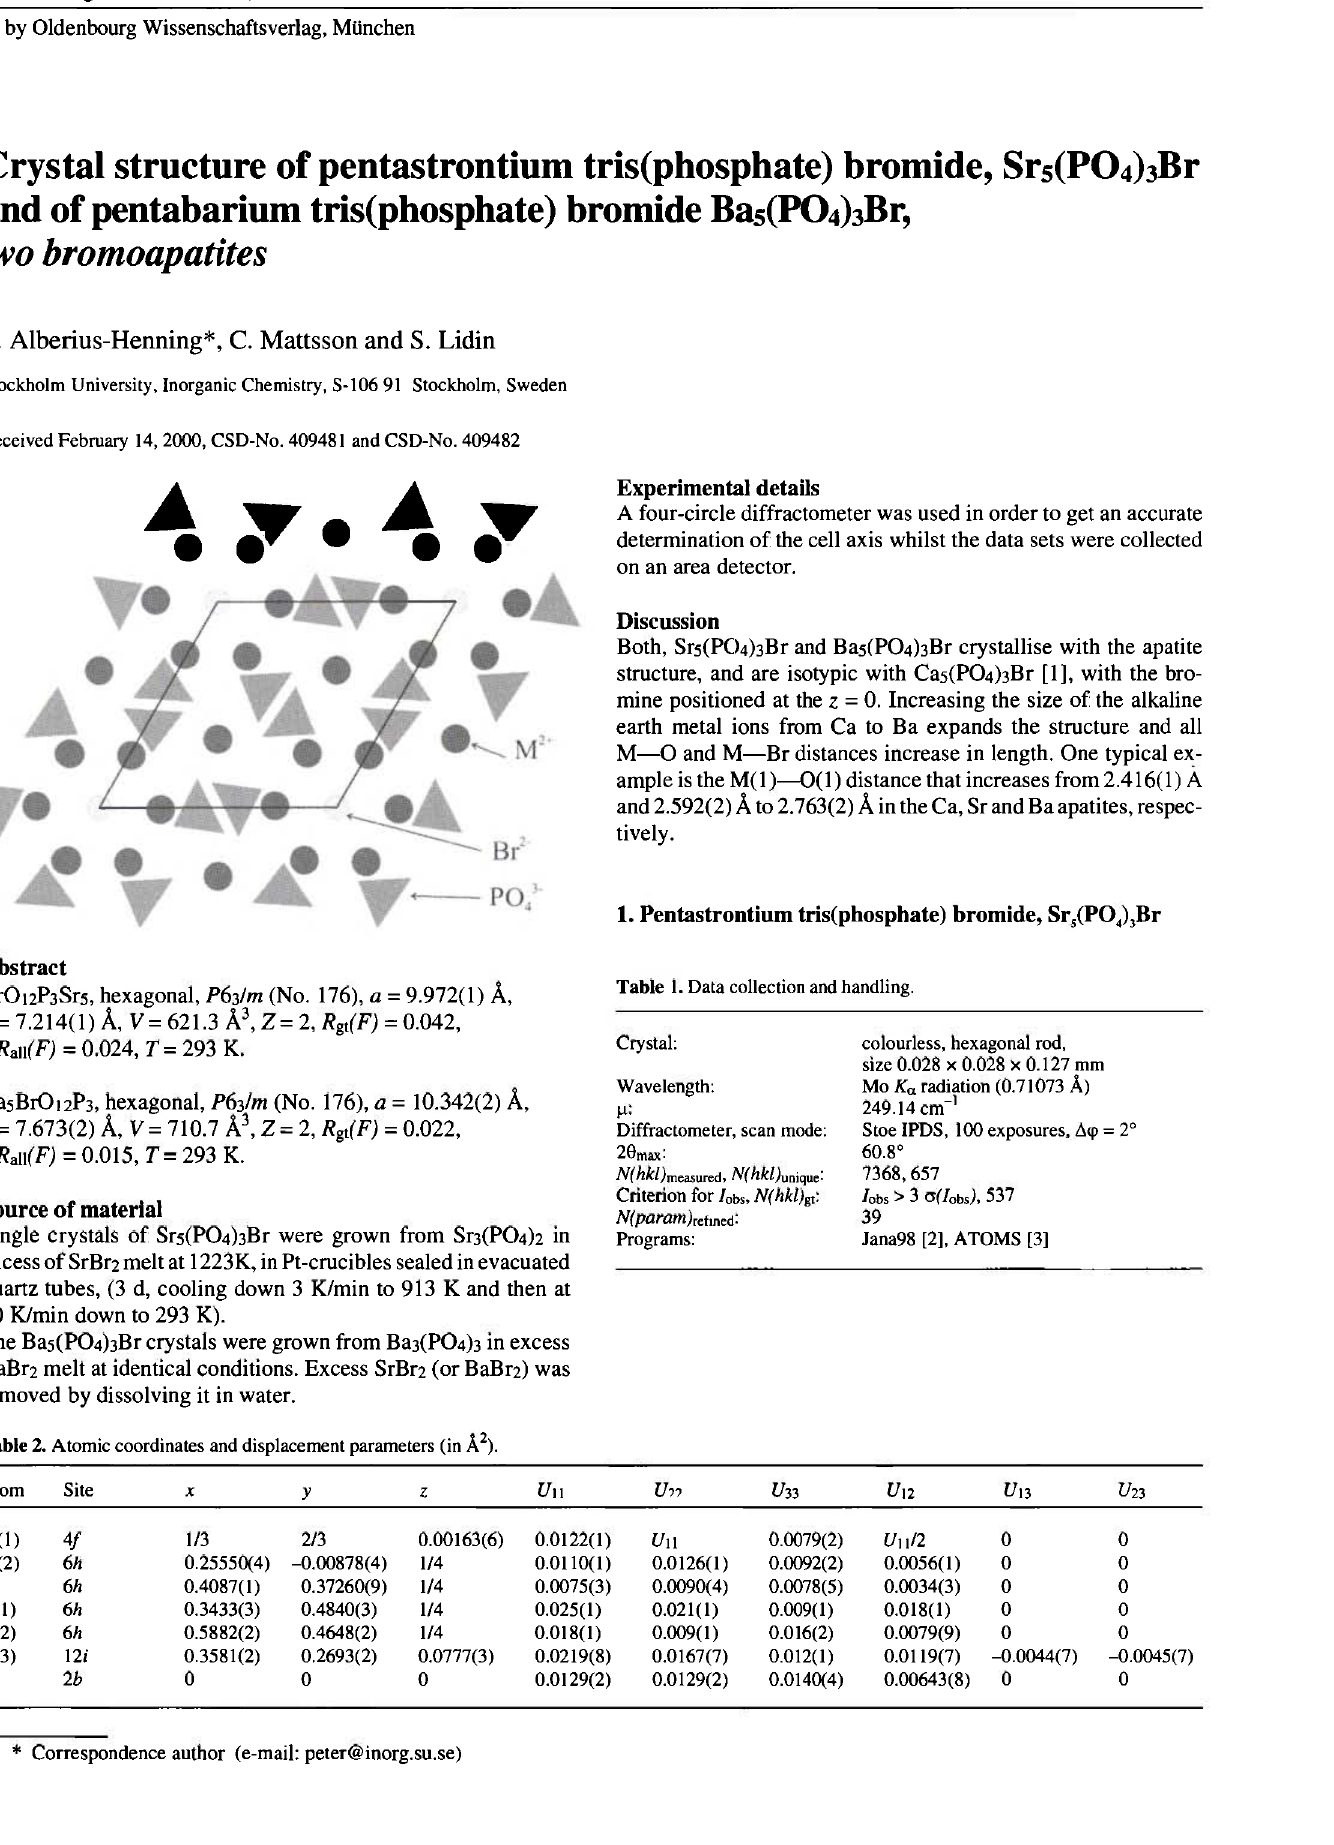
Table 2. Atomic coordinates and displacement parameters (in Ä 2 ).